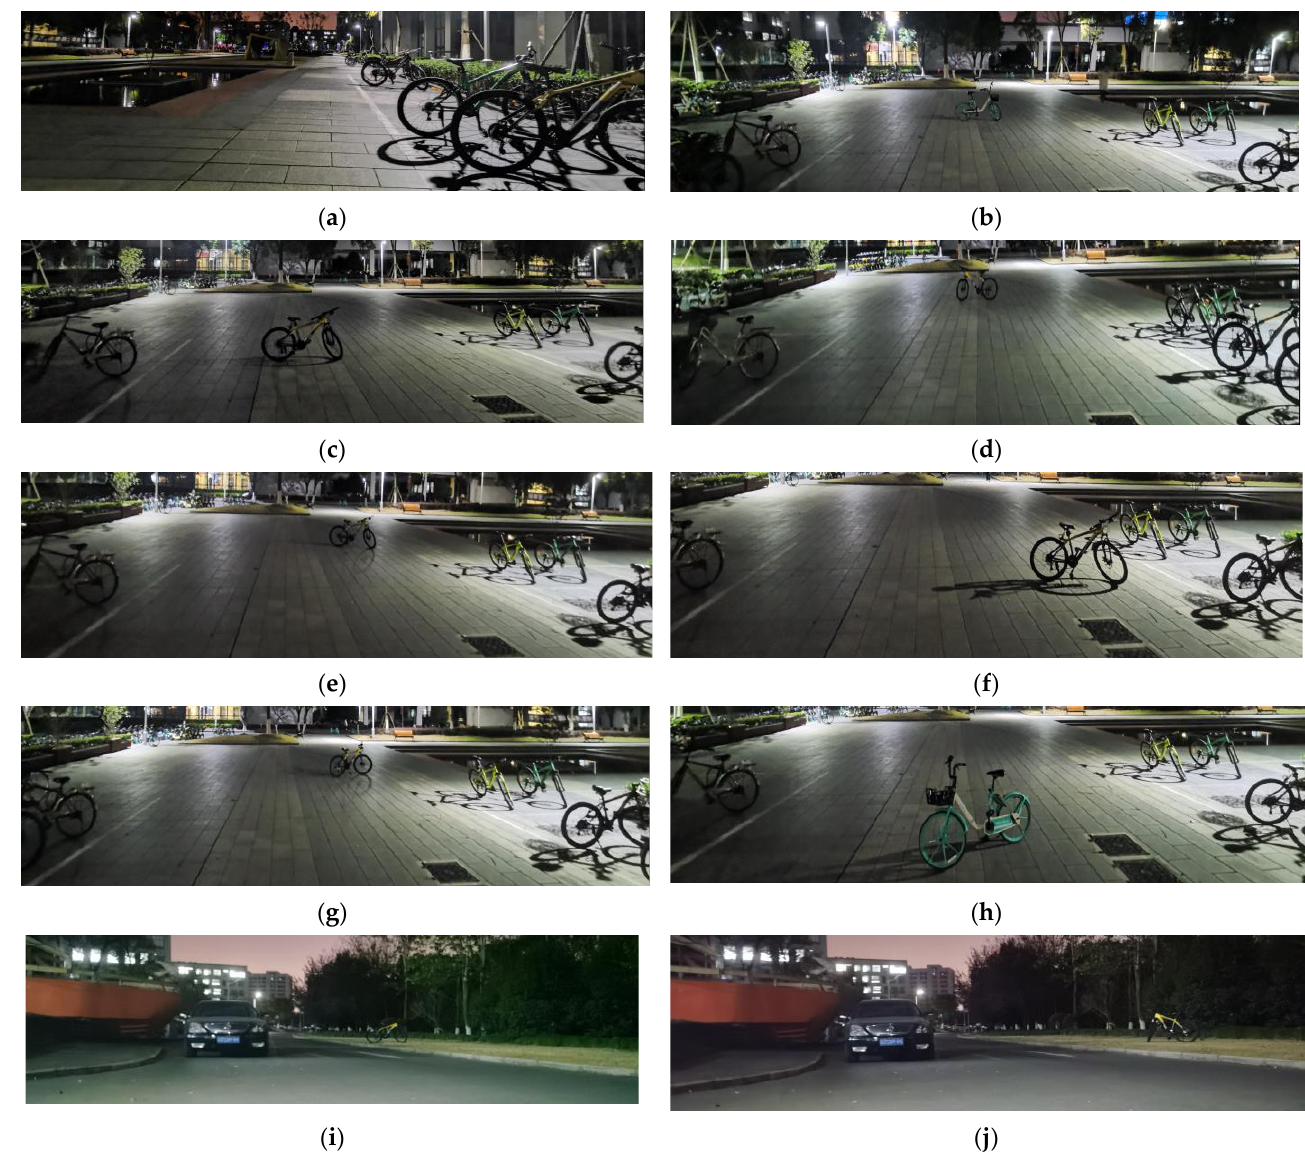
Figure 21. Some outdoor experimental scenes: ( a – j ) illsustrate the raw RBG images of the experimental scenes.